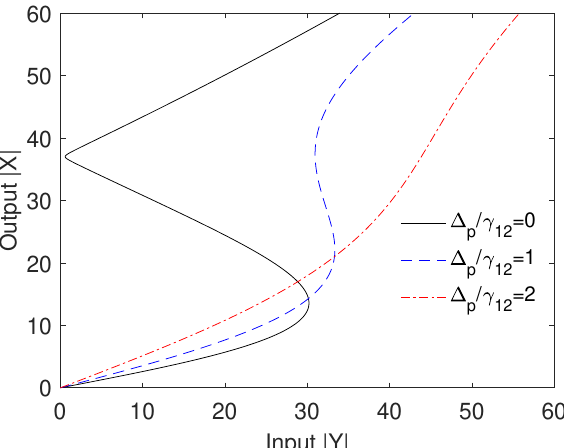
Figure 4. Output versus input for different values of the detuning of the probe field. The other ∆ = 6, Ω c = 1, R = 20nm, R = 5nm, θ c parameters are M γ 12 γ 12 mobility of GND is µ = 10 4 cm 2 V − 1 s − 1